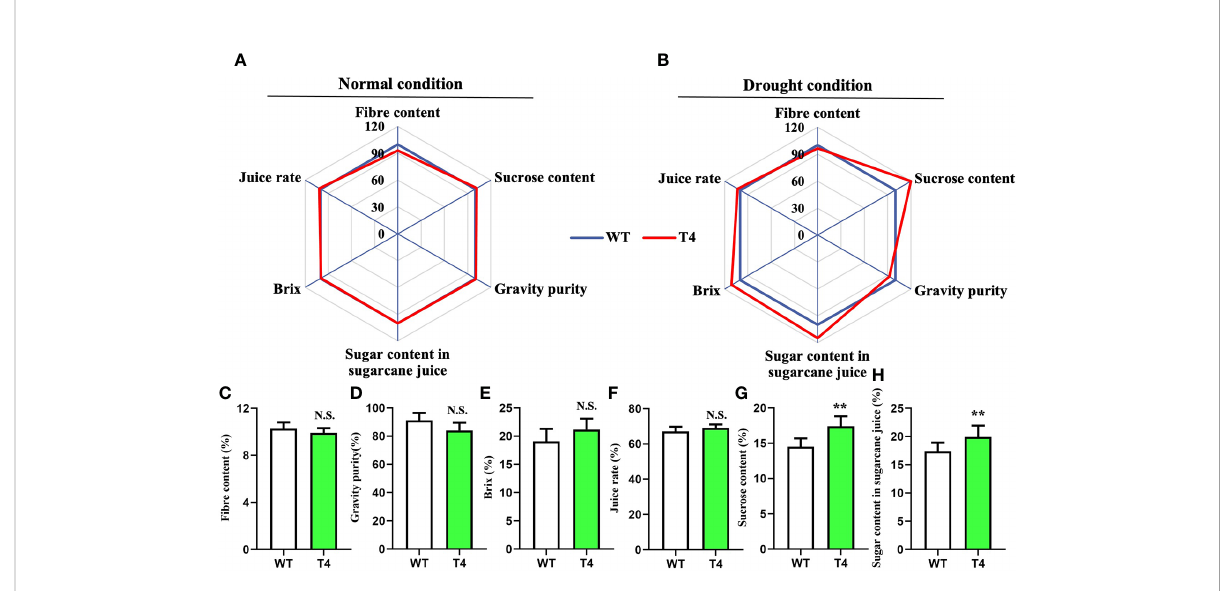
FIGURE 6 Quality traits of wild type (WT) and Prd29A:TaDREB2B transgenic sugarcane during water de fi cit in the fi eld. (A, B) Quality traits of Prd29A: TaDREB2B transgenic and WT plants grown in the fi eld under both normal (A) and drought (B) conditions. Mean values from WT were set at 100% as a reference. Each data point shows a percentage of the mean values. (C – H) Fiber content (C) , gravity purity (D) , Brix (E) , juice rate (F) , sucrose content (G) , and sugar content in sugarcane juice (H) of WT and Prd29A: TaDREB2B transgenic plants harvested under water-limited conditions. The values are the means ± SD; n=60 plants. All statistical analyses were performed using Student ’ s t -test: NS, no signi fi cance; ** P <